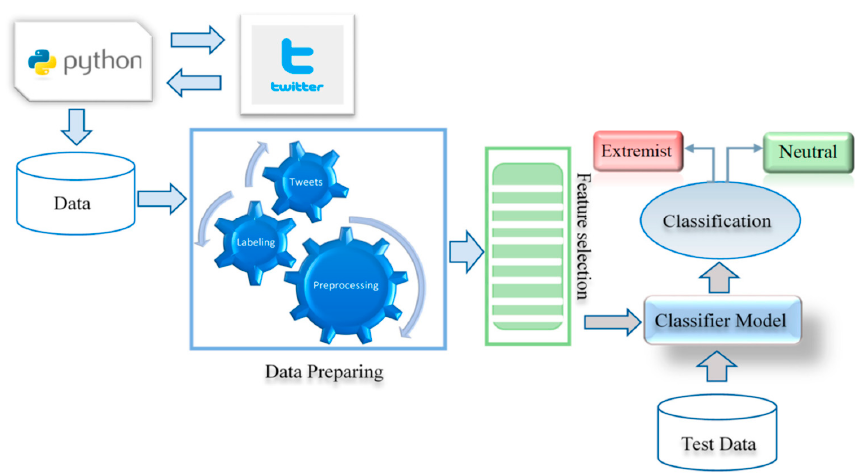
Figure 2. Proposed framework.